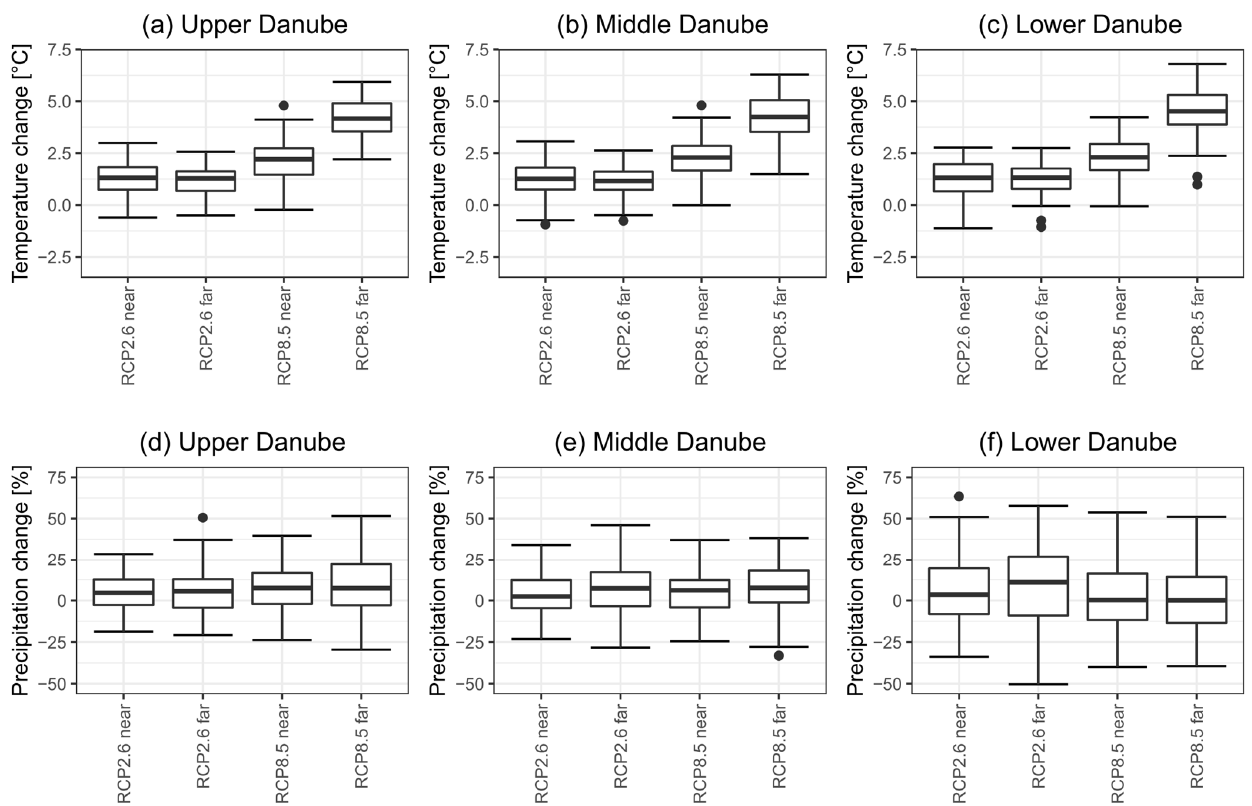
Figure 4. Boxplots of the annual temperature change [°C] ( a – c ) and the annual precipitation change [%] ( d – f ) on spatial average for the Upper, Middle and Lower Danube according to the simulations driven by the three individual GCM-RCM ensemble members under RCP2.6 and RCP8.5 for the near future (2031–2060) and the far future (2071–2100) compared to the long-term mean of the GCM-RCM-driven simulations for the historical period (1971–2000). The boxplots show yearly simulation results of the three individual GCM-RCM ensemble members. Whiskers: 1.5-fold interquartile range; black dots: minimum and maximum values.